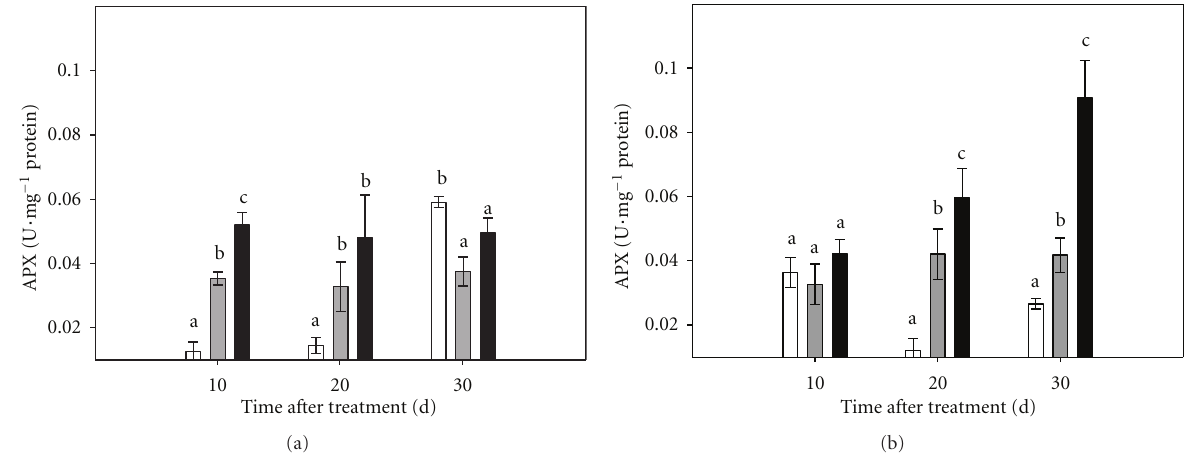
Figure 4: E ff ect of osmotic stress on APX activity in Carrizo citrange plants cultured in vitro . (a): aerial part of intact plants; (b): root tissue of intact plants. Control plants (white bar), plants cultured under moderate (grey bar) or severe (black bar) osmotic stress conditions. Each point corresponds to the average ± standard error of six independent determinations. Di ff erent letters denote statistical significance at P <